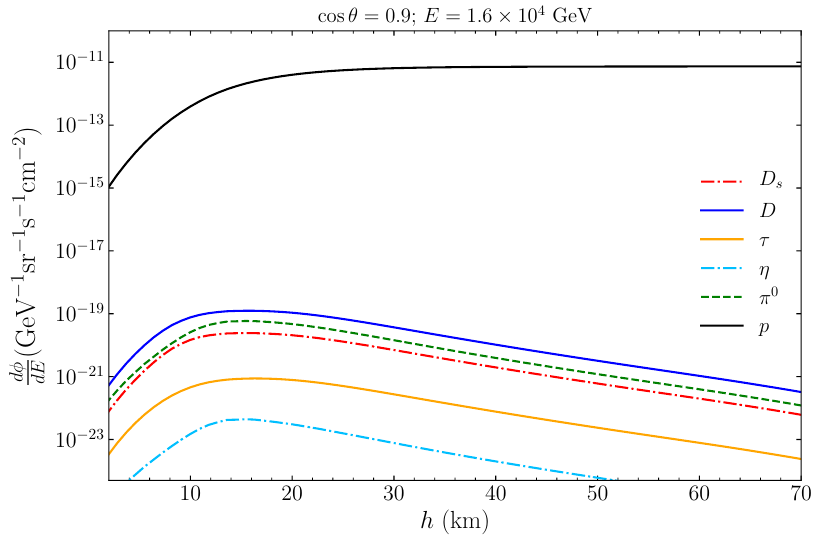
Figure 2 . Di(cid:11)erential (cid:13)uxes of LLP parent particles as a function of the height at (cid:12)xed energy, E = 1 : 56 (cid:1) 10 4